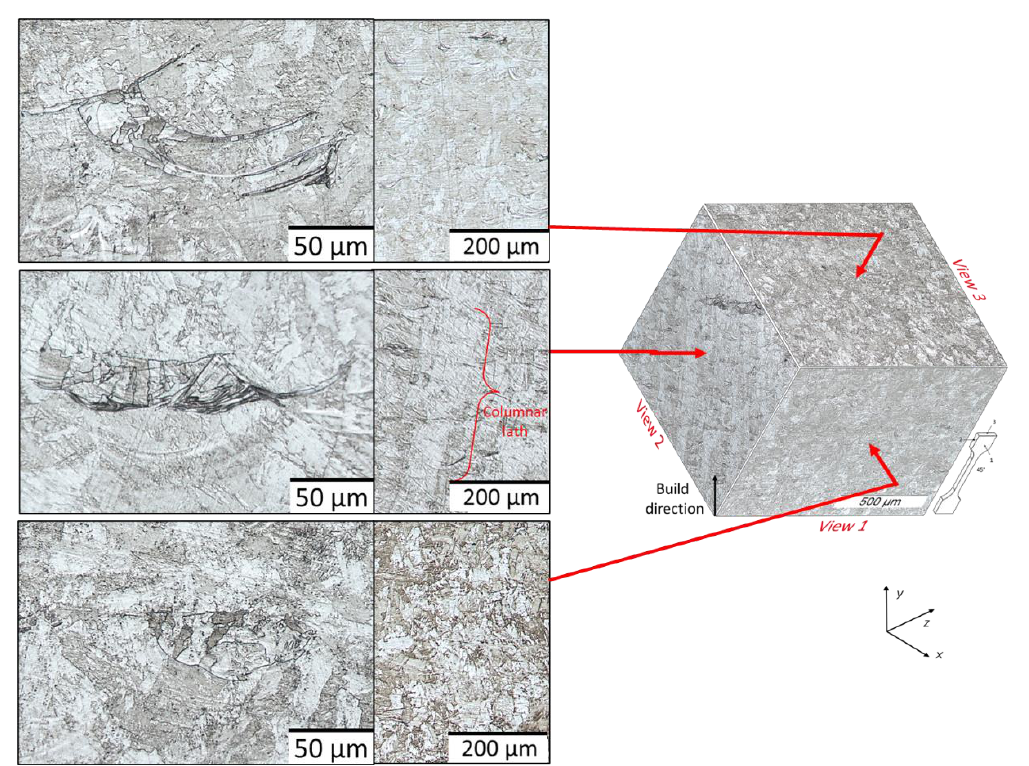
Figure 9. Microstructure profile for 45° build direction.